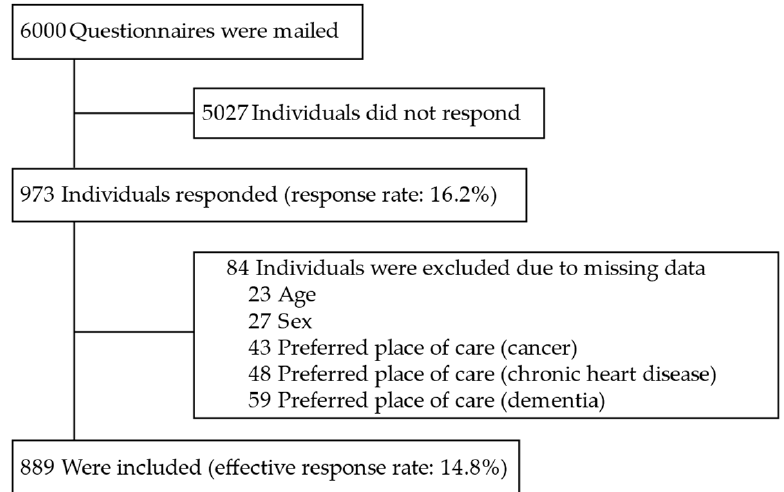
Figure 1. Flowchart of respondents. The 84 individuals missed at least one of the variables; the total number of missingness, therefore, exceeded 84.